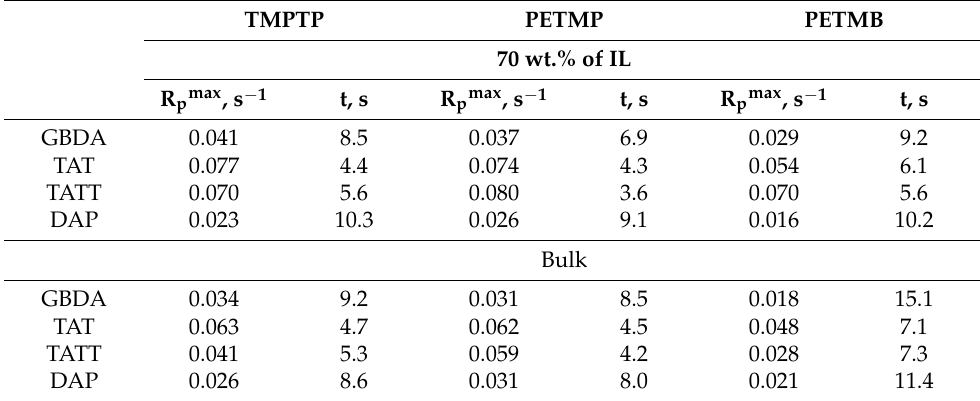
Table 4. Maximum polymerization rate (R pmax , s − 1 ) and time for reaching R pmax (t max , s). TMPTP